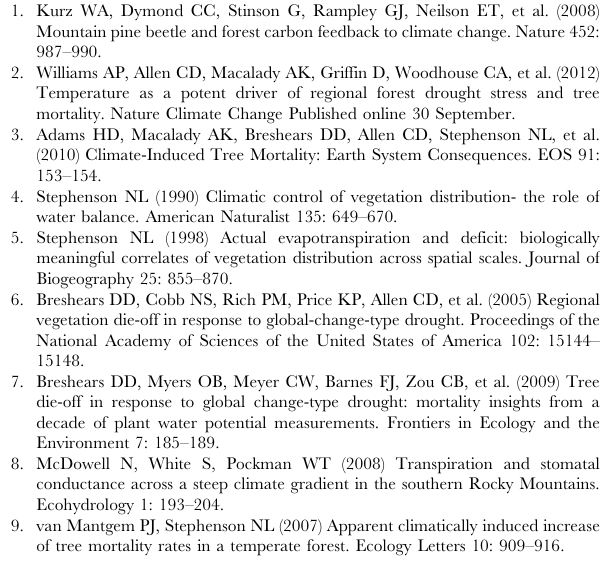
Figure S8 Projected Changes in Mortality Rate for predomi- nantly Energy-Limited Sierra Nevada Conifer Forests (PCM B1, Hypothetical). Mapped projections of average relative changes in mortality rate for the years 2090 to 2099 for energy-limited coniferous forests ( $ 2450 m) of California’s Sierra Nevada, using exponential models and the PCM B1 emissions model. Elevations generally increase from left to right. (A) Changes in mortality when absolute changes in deficit ( D a ) are used as a predictor. (B) Changes in mortality when relative changes in deficit ( D r ) are used as a predictor. (C) Changes in mortality when absolute changes in temperature (T a ) are used as a predictor. Table S1 Plot Details. Characteristics of the 21 forest plots used for model development. Table S2 Plot Mortality Data. Counts of mortalities and live trees for each plot for each census